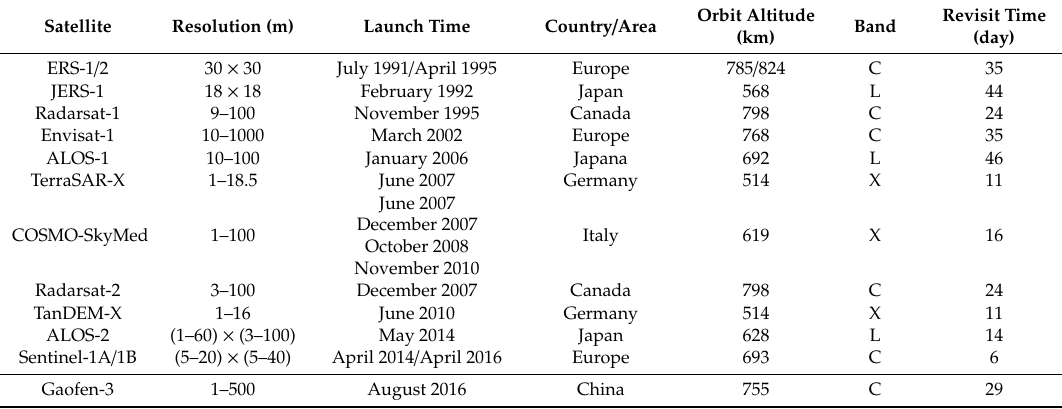
Table 1. Basic parameters of interferometric synthetic-aperture radar satellites globally and the Gaofen-3 satellite in particular.